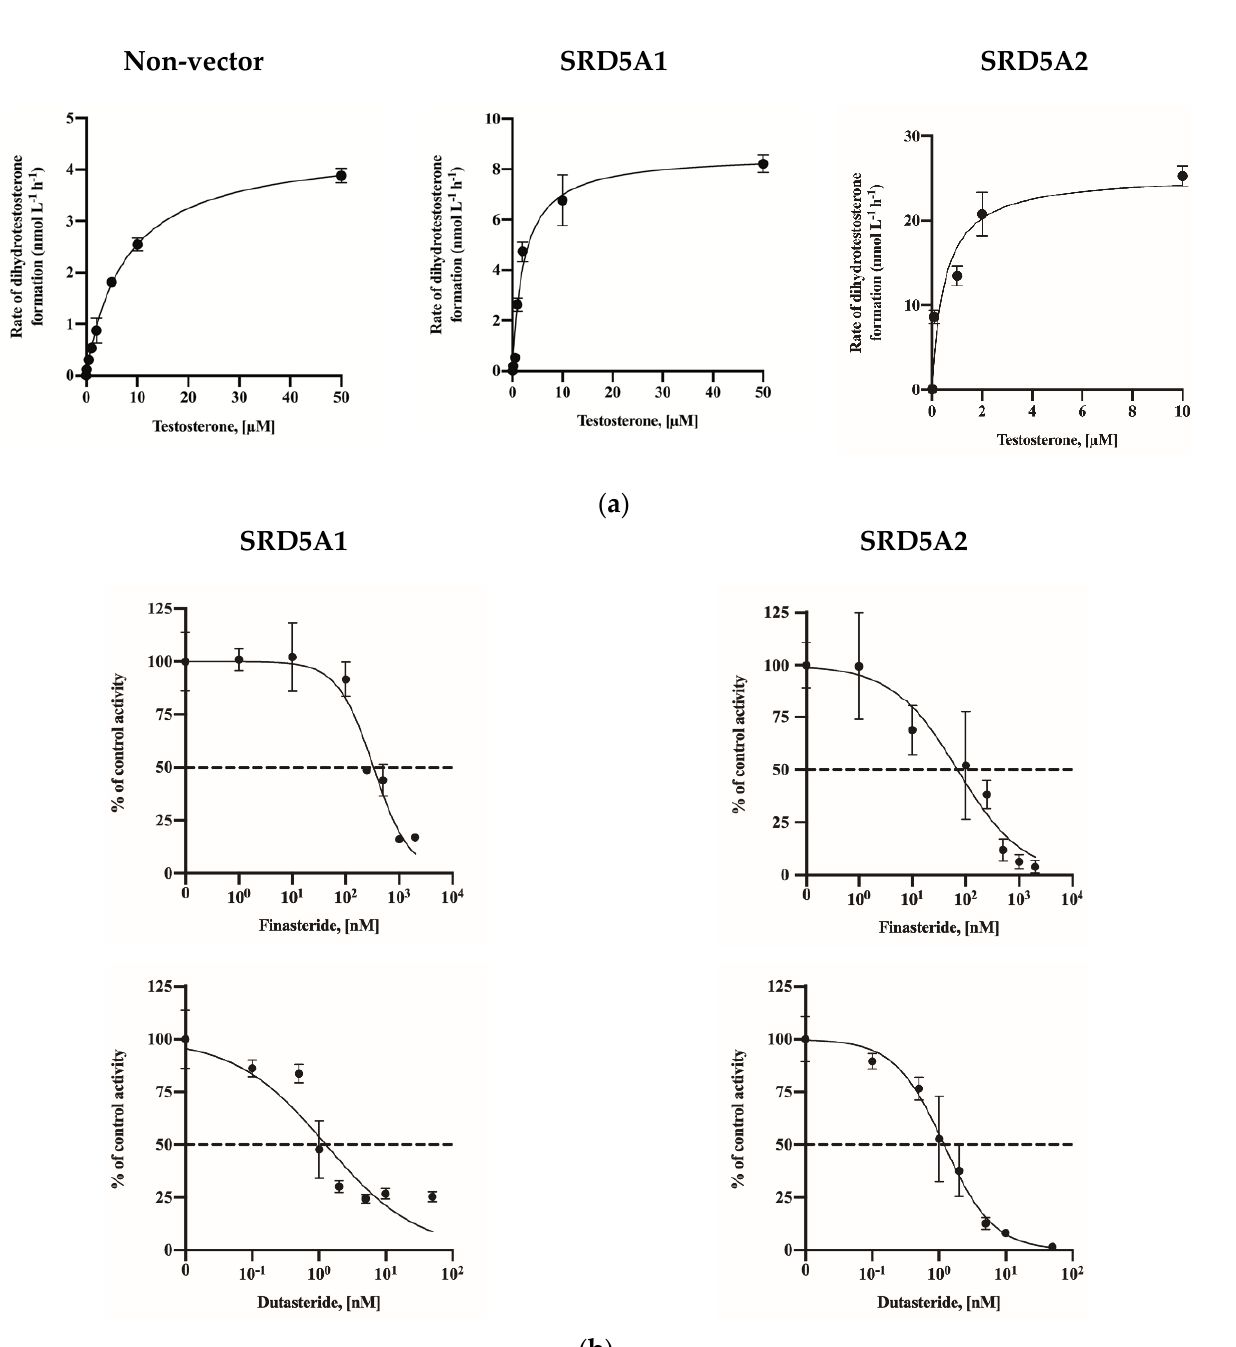
Figure 4. Activity of 5 α -reductase ( a ) and inhibitory effects of finasteride and dutasteride ( b ) on transfected HEK-293 cells. The data are expressed as the mean ± standard deviation (SD) of three repeated experiments.